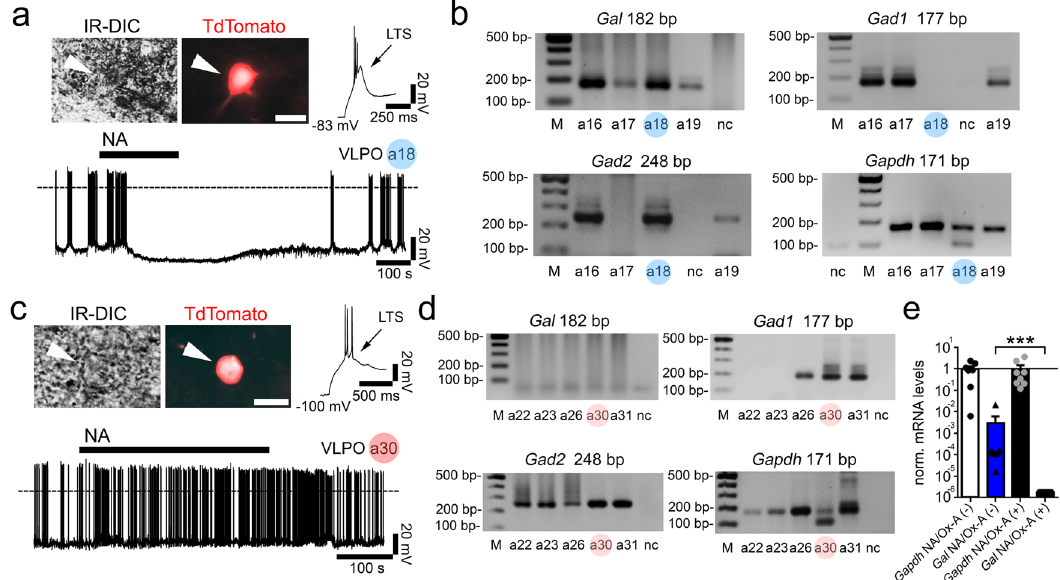
Fig. 3 Pharmacological and molecular diversity of the VLPO GABAergic neurons. We recorded from TdTomato labeled VLPO Vgat( + ) (VLPO Vgat ) neurons in Vgat-IRES-Cre mice injected into the VLPO with AAV-DIO-TdTomato . VLPO Vgat neurons ( a top; TdTomato-labelled; sample #a18; scale bar: 20 μ m) that are inhibited by NA (50 μ M) express galanin. Single-cell RT-PCR results from 4 VLPO neurons inhibited by NA ( b ). The VLPO Vgat neurons ( c top ; TdTomato-labelled; sample #a30; scale bar: 20 μ m) that are excited by NA do not express galanin. Single-cell RT-PCR results from 5 VLPO Vgat neurons excited by NA ( d ). Gal (182 bp), Gad1 (177 bp), Gad2 (248 bp), and Gapdh (171 bp; housekeeping gene), M marker ladder, nc negative control. e scRT-sqPCR results con fi rming the presence of galanin mRNA in 7 VLPO Vgat neurons inhibited by NA and/or Ox-A (NA/Ox-A( − )) and the absence of galanin mRNA in 8 VLPO Vgat neurons excited by NA and/or Ox-A (NA/Ox-A( + )). Mann – Whitney unpaired one-sided t -test, Gal NA/Ox-A( − ) vs Gal NA/ Ox-A( + ); p = 0.0002, *** p < 0.001; values normalized to the mean Gapdh . e data are represented as means ± SEM. Panels b , d , and e Source Data are provided as a Source Data fi